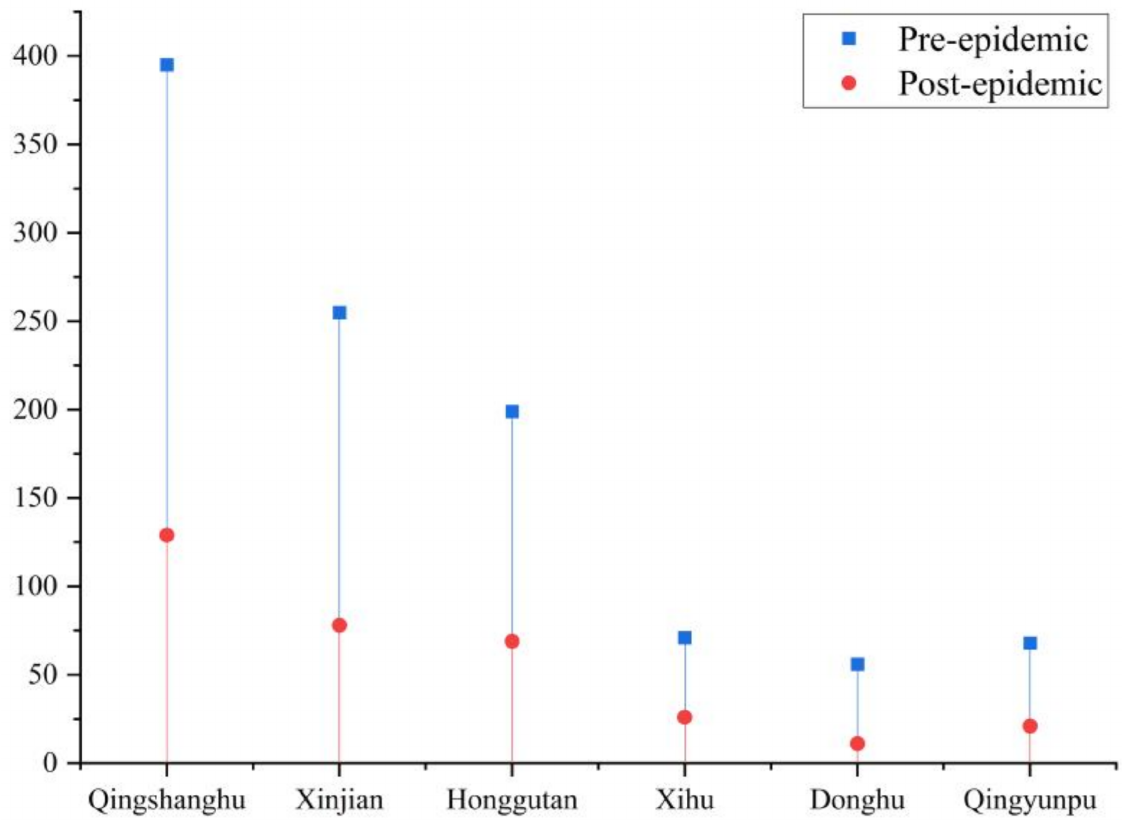
Figure 5. The number of outdoor sports venues in each district.